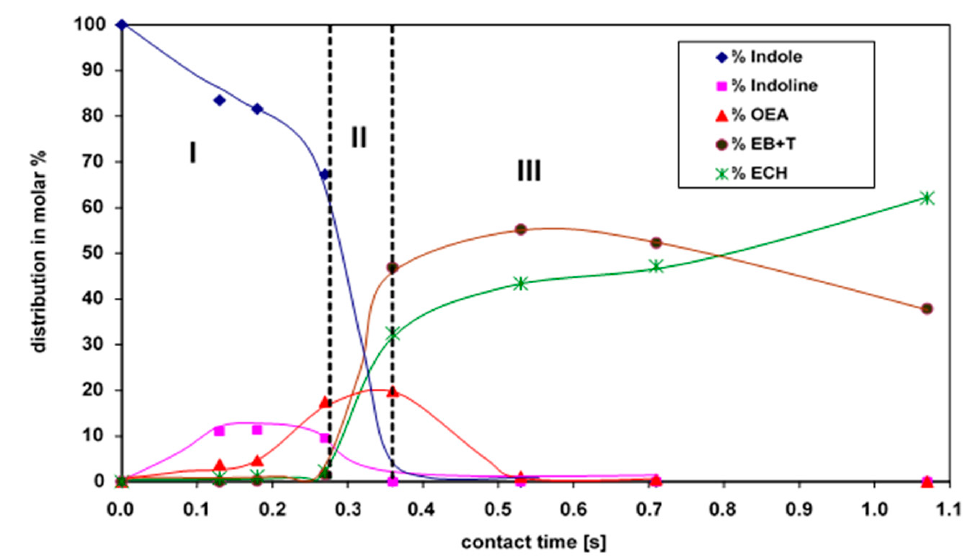
Figure 3. Distribution of the products of HDN of indole at different contact times in the presence of 50 ppm of sulfur over Mo 2 C at 613 K, 6 MPa, H 2 /feed = 600.